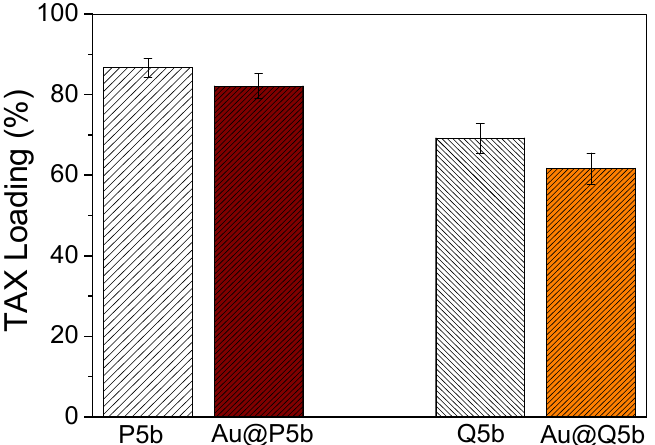
Figure 7. TAX loading (%) in pentablock terpolymer bare and hybrid micelles, in PBS at pH 7.4. Each point is the mean from three independent measurements and bars represent standard deviation of means.